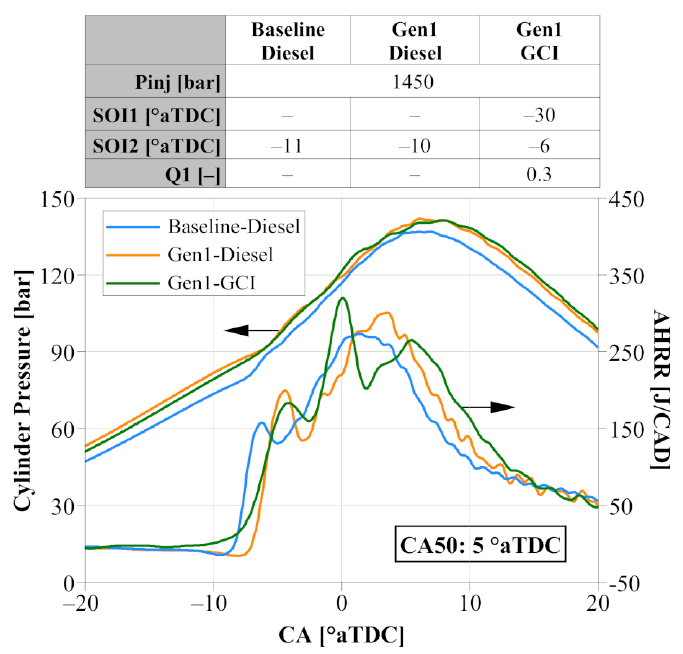
Figure 13. Global combustion behavior for Baseline-Diesel, Gen1-Diesel, and Gen1-GCI at B50.